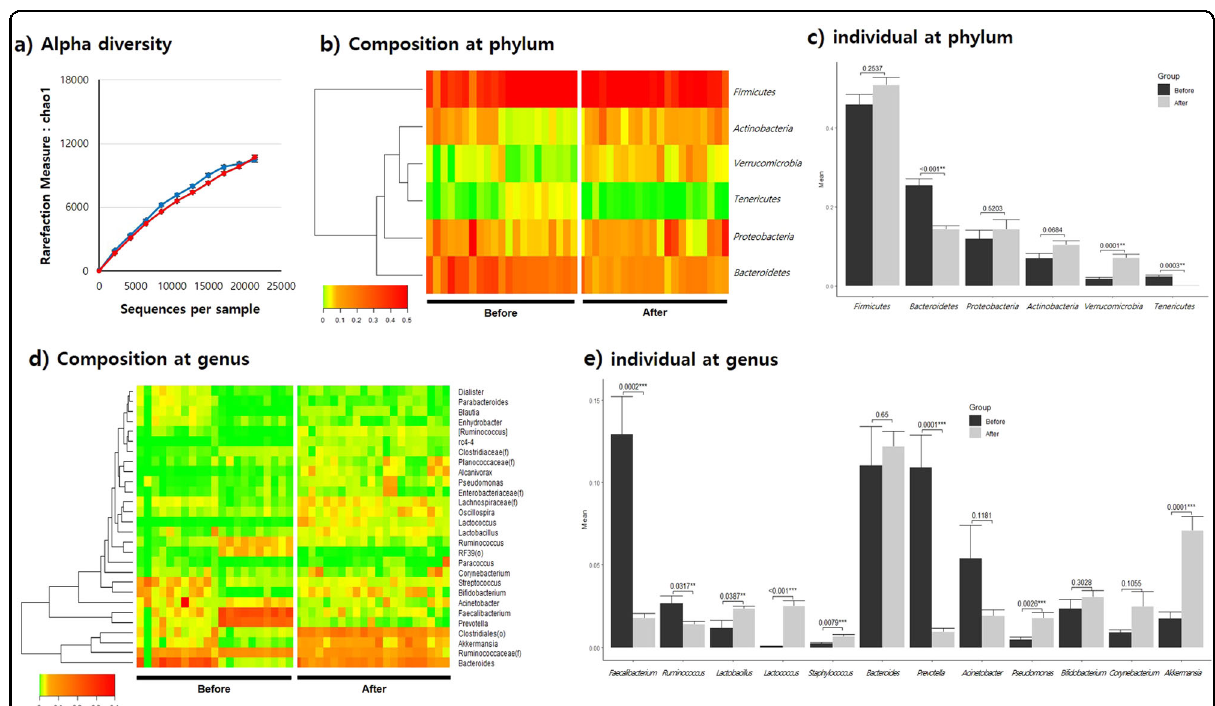
Fig. 3 Composition of microbiota-derived urinary EVs before and after consumption of a synbiotic beverage. a Alpha diversity measured by Chao1, b composition of the microbiome at the phylum level, c individual microbiome at the phylum level, d composition of the microbiome at the genus level, and e individual microbiome at the genus level